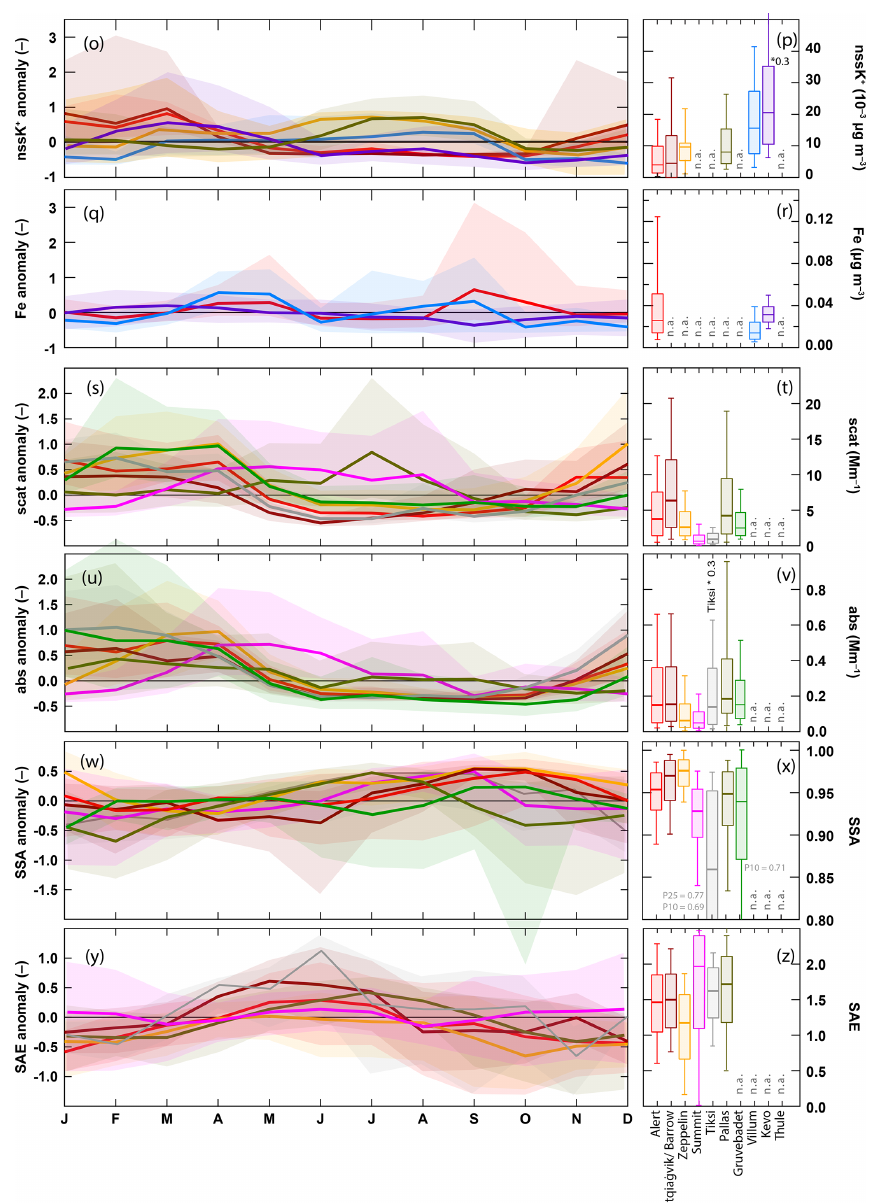
Figure 2. The left column shows annual cycles of aerosol chemical compounds and physical properties for each available data set as anomaly. The data are normalized by the median and interquartile range (see Methods). Colors represent stations given in the right column of the figure (see panel b ). The right column provides statistical values (median, interquartile range, and 10th and 90th percentiles) per variable and station. Chemical compounds were derived from the following size ranges (see also Table 1): TSP for Alert and Villum, PM 10 for Zeppelin, and PM 1 for Barrow/Utqia ˙